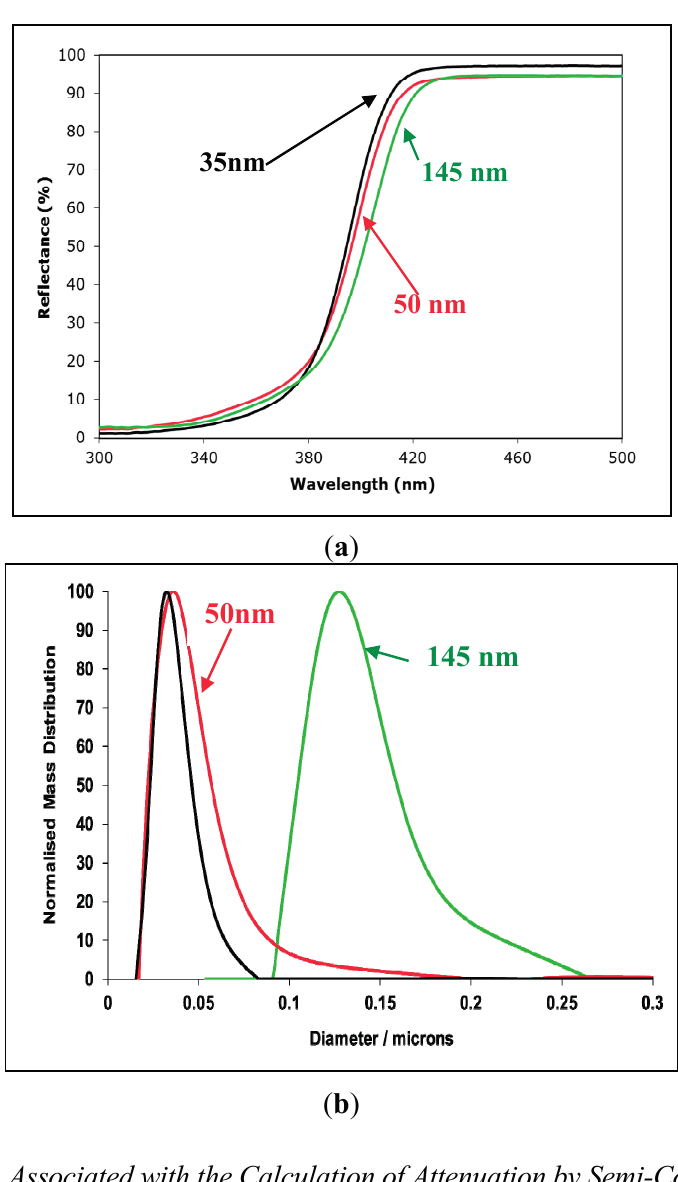
Figure 5. ( a ) The reflectance spectra (measured on a Jasco 670 spectrometer fitted with an integrating sphere) of pressed discs made from the three different rutile samples of mean size 35 ─ ; 50 ─ and 145 ─ whose suspension spectra are shown in Figure 4 and whose size distributions are shown in Figure 5b; ( b ) The particle-size distributions measured by X-ray size sedimentation (Brookhaven X-ray disc sedimentometer) of three rutile samples (reprinted with permission from Egerton & Tooley, International Journal of Cosmetic Science 2012 , 34 , 117–122 [23] published by Society of Cosmetic Sciences; Société Française de Cosmétologie and Blackwell